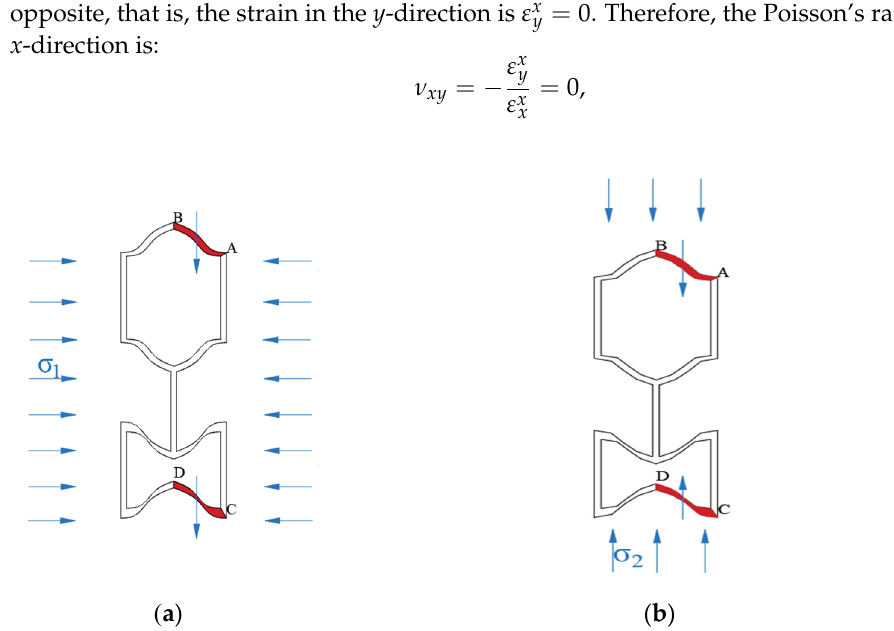
Figure 3. Uniaxial compressive of the honeycombs. ( a ) x -axis loading, ( b ) y -axis loading.